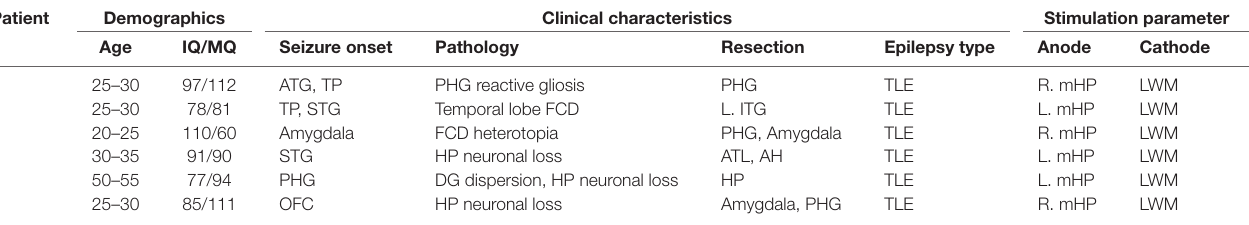
TABLE 1 | Patient demographics, clinical characteristics, electrode locations, and stimulation